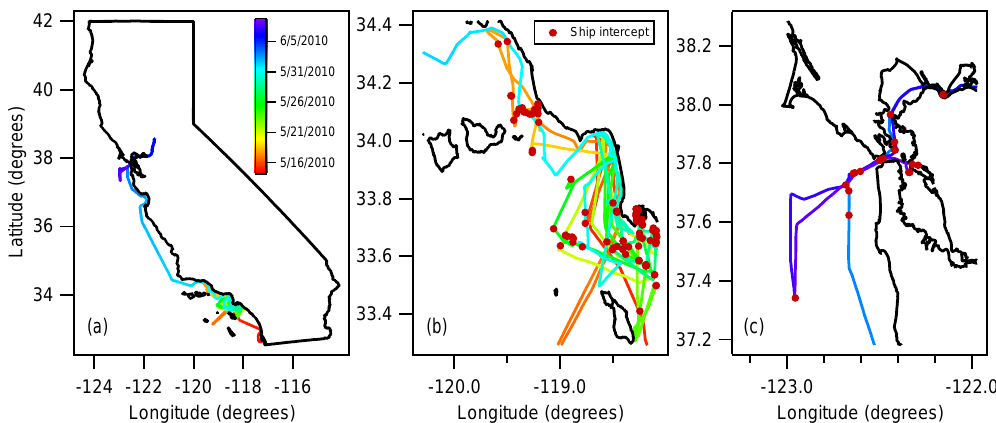
Fig. 1. Maps showing R/V Atlantis ship tracks for (a) the entire campaign, (b) southern CA near Los Angeles and (c) northern CA near San Francisco, along with locations of ship plume intercepts ( b, c